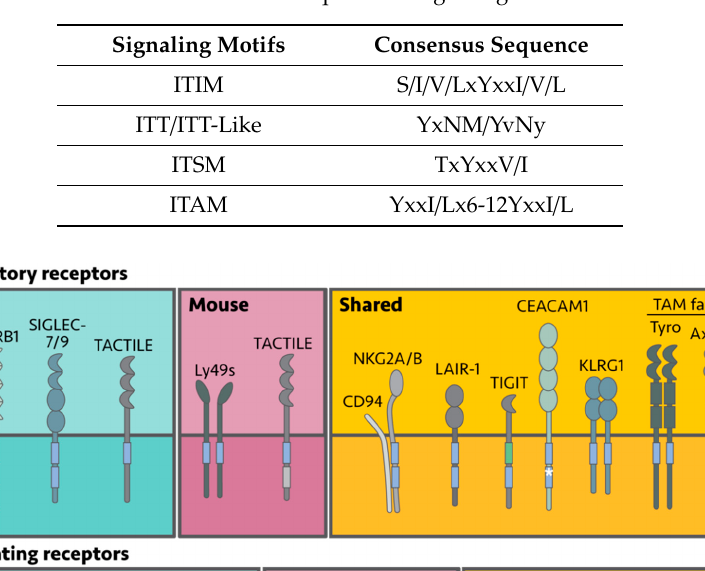
Table 1. Consensus sequence of signaling motifs.